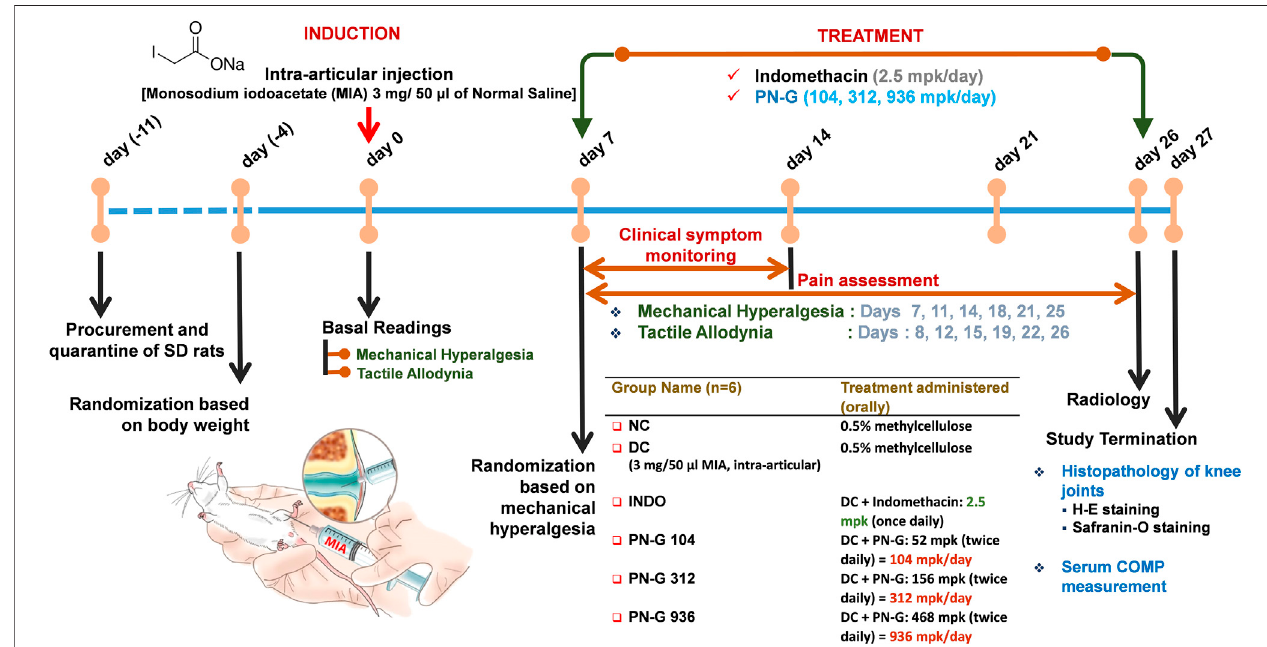
FIGURE 3| Schematic of the in vivo experiments. Followingquarantine and acclimatization, baseline readings of the employed pain parameters were recorded for allanimals.Thereafter,MIAwasinjected intotherightkneejointsofallanimalsexceptthoseintheNC.RatsinNCgroupwereadministeredsalinebyintra-articular route. Seven days post-MIA injection, animals were assessed for the development of mechanical hyperalgesia for randomization to receive different designated treatments, thenceforth. Rats received either indomethacin (2.5 mpk/day) or three different doses of PN-G (104, 312 and 936 mpk/day). Animals in NC and DC groups received methylcellulose. Mechanical hyperalgesia and tactile allodynia were recorded at an interval of every 3 – 4 days until day 26, when the animals were additionally subjectedtoradiologicalexamination.Onday27,animalswereeuthanizedandbloodwascollectedformeasurementoftheserumosteoarthriticbiomarker,COMP.The right knee joints were harvested for histopathological evaluation through H-E and Safranin-O staining.